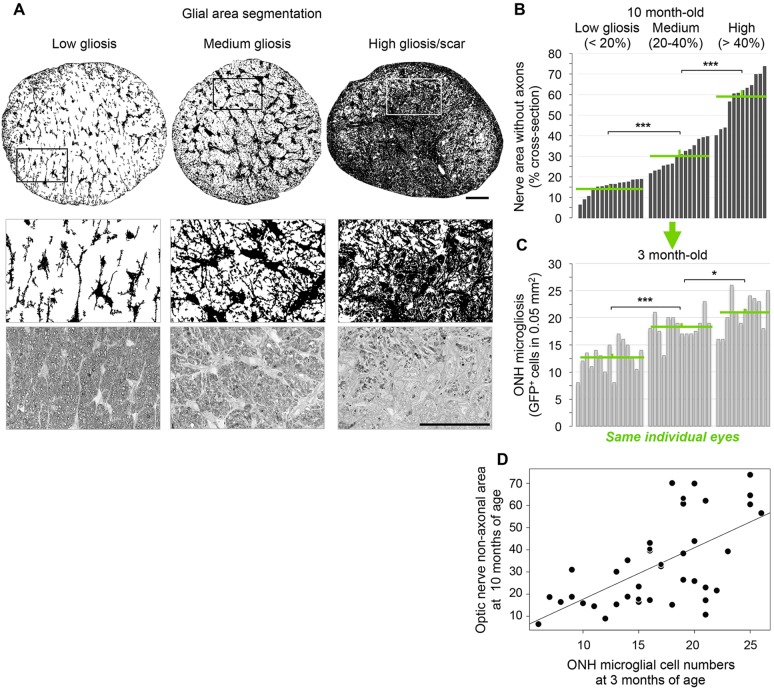
Severity of nerve pathology and early microgliosis show a positive correlation. (A) Threshold analysis of the nerve area occupied by glial cells or scar for the cross-sections in Fig. 4C, and high-magnification views of framed areas. (B) Plot of individual optic nerves from 10-month-old mice sorted by relative glial area and ascending coverage, and classified as low, medium and high gliosis (15.24±0.96, 30.38±1.67 and 59.05±3.22 mean±s.e.m. non-axonal area, respectively). Nerves show a spectrum of glaucomatous damage, with significant increases in mean gliosis across groups (***P<0.001; Student's t-test). (C) Corresponding microgliosis level or total GFP+ cell number per ONH at 3 months, plotted by their glial area at 10 months (i.e. same order as in B). Microgliosis is categorized by level as low, medium and high microgliosis (12.63±0.70, 18.43±0.62 and 21.08±0.97 mean cells per ONH, respectively). The mean ONH microgliosis shows significant increases across levels of nerve gliosis (***P<0.001 and *P<0.05; n=41 eyes; Student's t-test). Green lines indicate means and s.e.m. per group. (D) There is significant correlation between the optic nerve glial relative area at 10 months (non-axonal area) and their ONH microgliosis at 3 months (P=0.0001; Spearman's rank test). Scale bars: 50 µm.